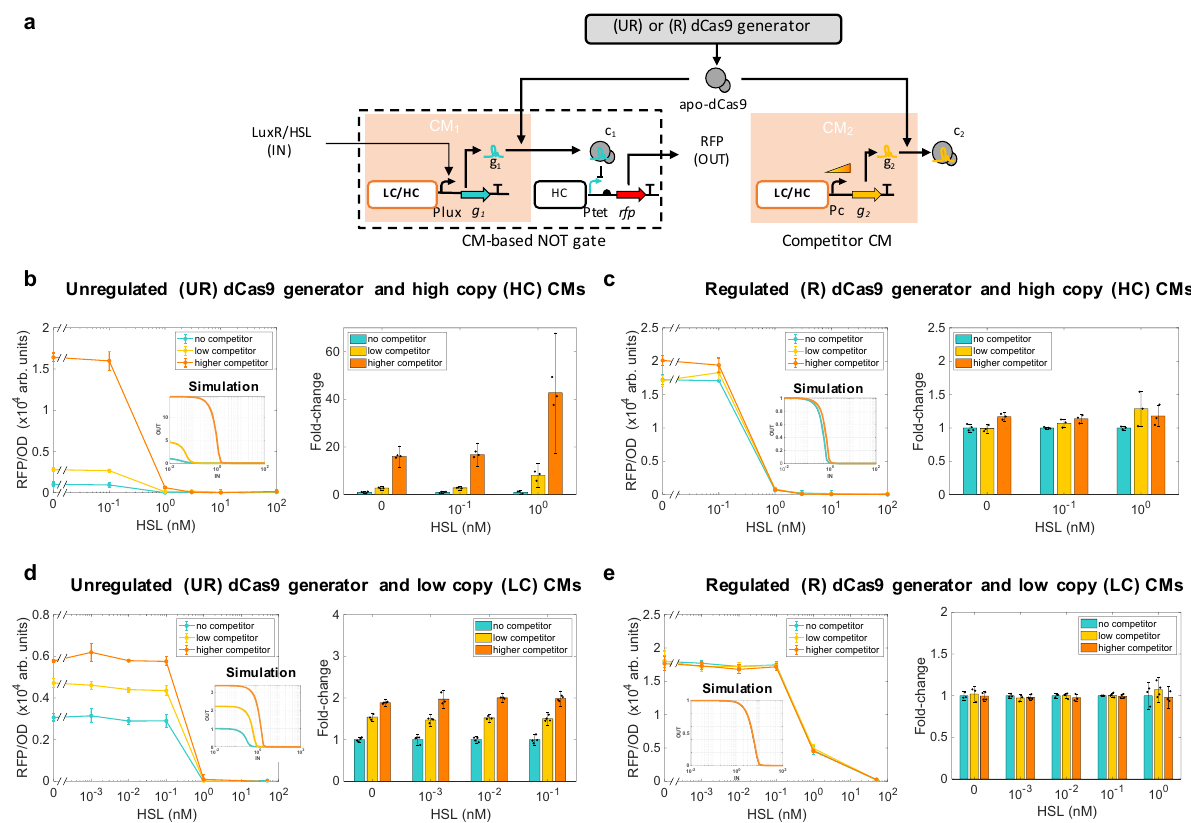
Fig. 2 Effect of competitor CM on CM-based NOT gate with UR and R dCas9 generators. a Genetic diagram of a CM-based NOT gate and competitor CM. The NOT gate is composed of a CM comprising sgRNA g 1 , giving complex c 1 as an output, and of a genetic module that takes c 1 as input and gives RFP as an output. Here, g 1 ’ s expression is regulated by HSL/LuxR (IN). A competitor CM that expresses competitor sgRNA g 2 with variable promoter Pc is either present or absent. The CMs were placed either on a low copy (LC) number plasmid (~5 copies) or on a high copy (HC) number plasmid (~84). The dCas9 generator was placed on a medium (~20) copy number plasmid (Supplementary Notes 6). b CM-based NOT gate I/O response with UR dCas9 generator and CMs on HC plasmid. Turquoise line represents I/O responses in the absence of competitor, while yellow (medium competitor) and orange (higher competitor) lines represent system I/O responses in which the expression of g 2 is driven by a weaker (BBa_J23100) or stronger (pTrc) promoter, respectively (Supplementary Note 6 and Supplementary Table 13). Inset shows steady state I/O responses obtained by simulating the ODE model of the unregulated system described by Supplementary Eqs. (30 – 32) with parameters in Supplementary Table 3. ( c ) CM-based NOT gate I/O response with R dCas9 generator and CMs on HC plasmid. Inset shows steady state I/O responses obtained by simulating the ODE model of the regulated system described in Supplementary Eqs. (33 – 35) with parameters in Supplementary Table 3. RFP distributions obtained by fl ow cytometry are reported in Supplementary Fig. 12. d CM-based NOT gate I/O response with UR dCas9 generator and CMs on LC plasmid. Yellow (medium competitor) and orange (higher competitor) lines represent system I/O responses in which the expression of competitor sgRNA is driven by a weaker (BBa_J23116) or stronger promoter (BBa_J23100), respectively (See Supplementary Note 6 and Supplementary Table 13). Inset shows steady state I/O responses obtained by simulating the ODE model of the unregulated system described by Supplementary Eqs. (30 – 32) with parameters in Supplementary Table 3. e CM-based NOT gate I/O response with R dCas9 generator and CMs on LC plasmid. Inset shows steady state I/O responses obtained by simulating the ODE model of the regulated system described in Supplementary Eqs. (33 – 35) with parameters in Supplementary Table 3. Data in the line plots represent mean values ± SD of n = 3 or 4 biologically independent experiments. Fold changes are normalized to the no competitor data. Bar graphs with error bars and overlaid dot plots are computed according to Eqs. (1 – 3) in “ Methods ” section. Insets ’ IN and OUT have the same units as in the data plots. Source data are provided with this